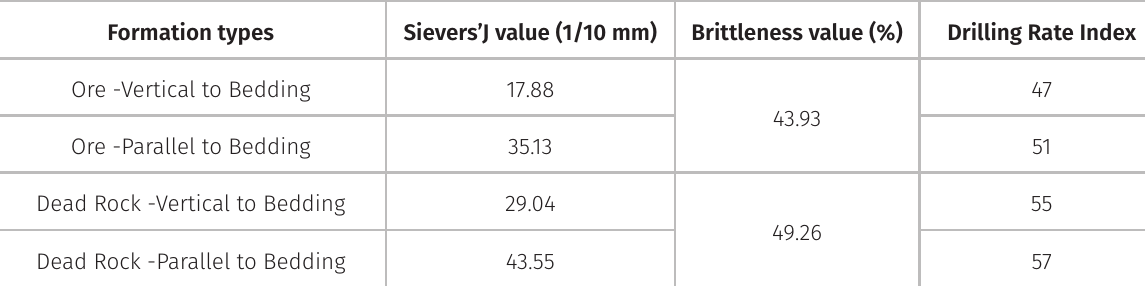
Table IV. Average drilling depths and drilling speeds for different bedding conditions. Table V . Drillability (DRI) values of Ore and Dead rock. Formation types